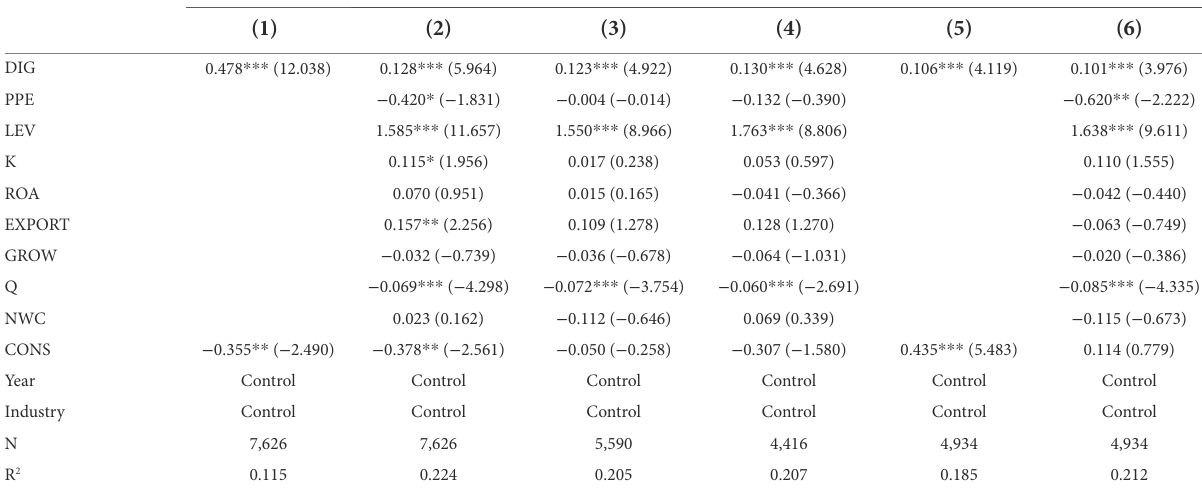
TABLE 5 OFDI_2 basic regression results.